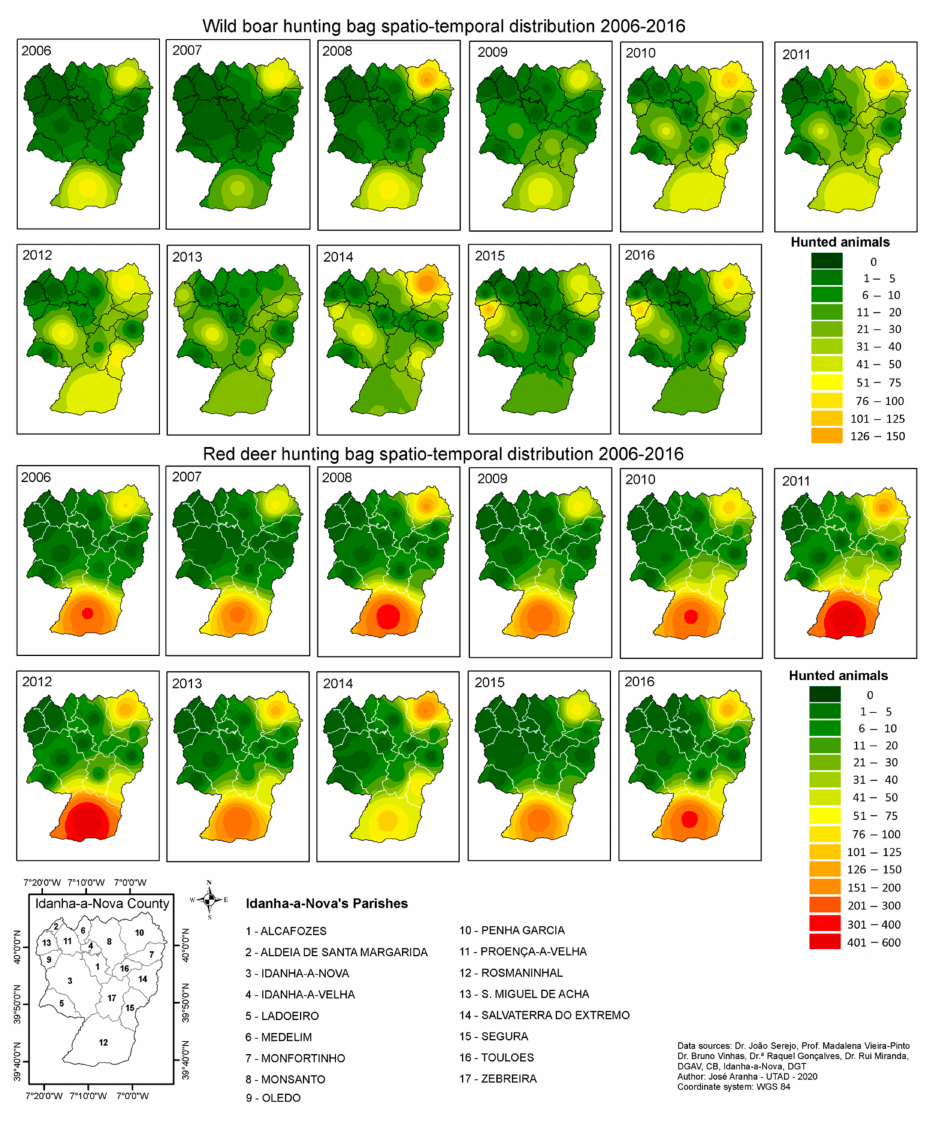
Figure 7. Hunting bag spatial–temporal distribution within Idanha-a-Nova county from 2006 to 2016. ( top ): wild boar; ( bottom ): red